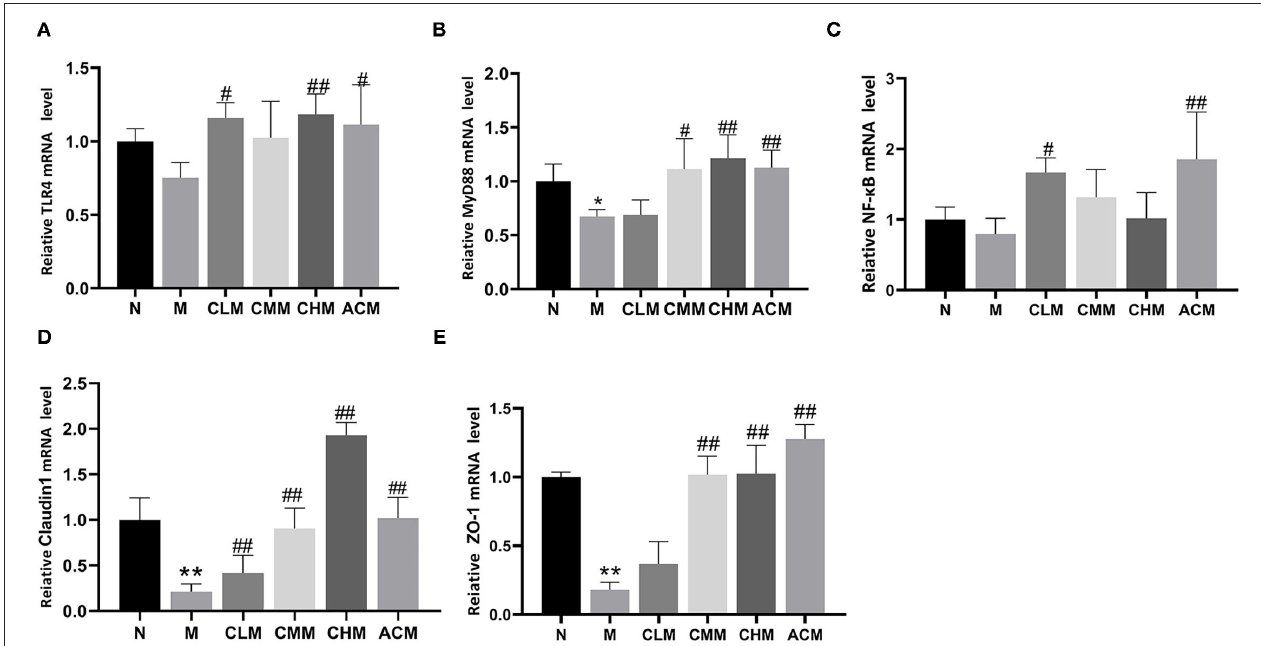
FIGURE 9 | Effects of CSP on relative mRNA expression in jejunum. (A) The mRNA expression of TLR4. (B) The mRNA expression of MyD88. (C) The mRNA expression of NF- κ B. (D) The mRNA expression of Claudin1. (E) The mRNA expression of Zo-1. Data are expressed as mean ± SD.* p < 0.05 and ** p < 0.01 compared with N group; # p < 0.05 and ## p < 0.01 compared with M group.